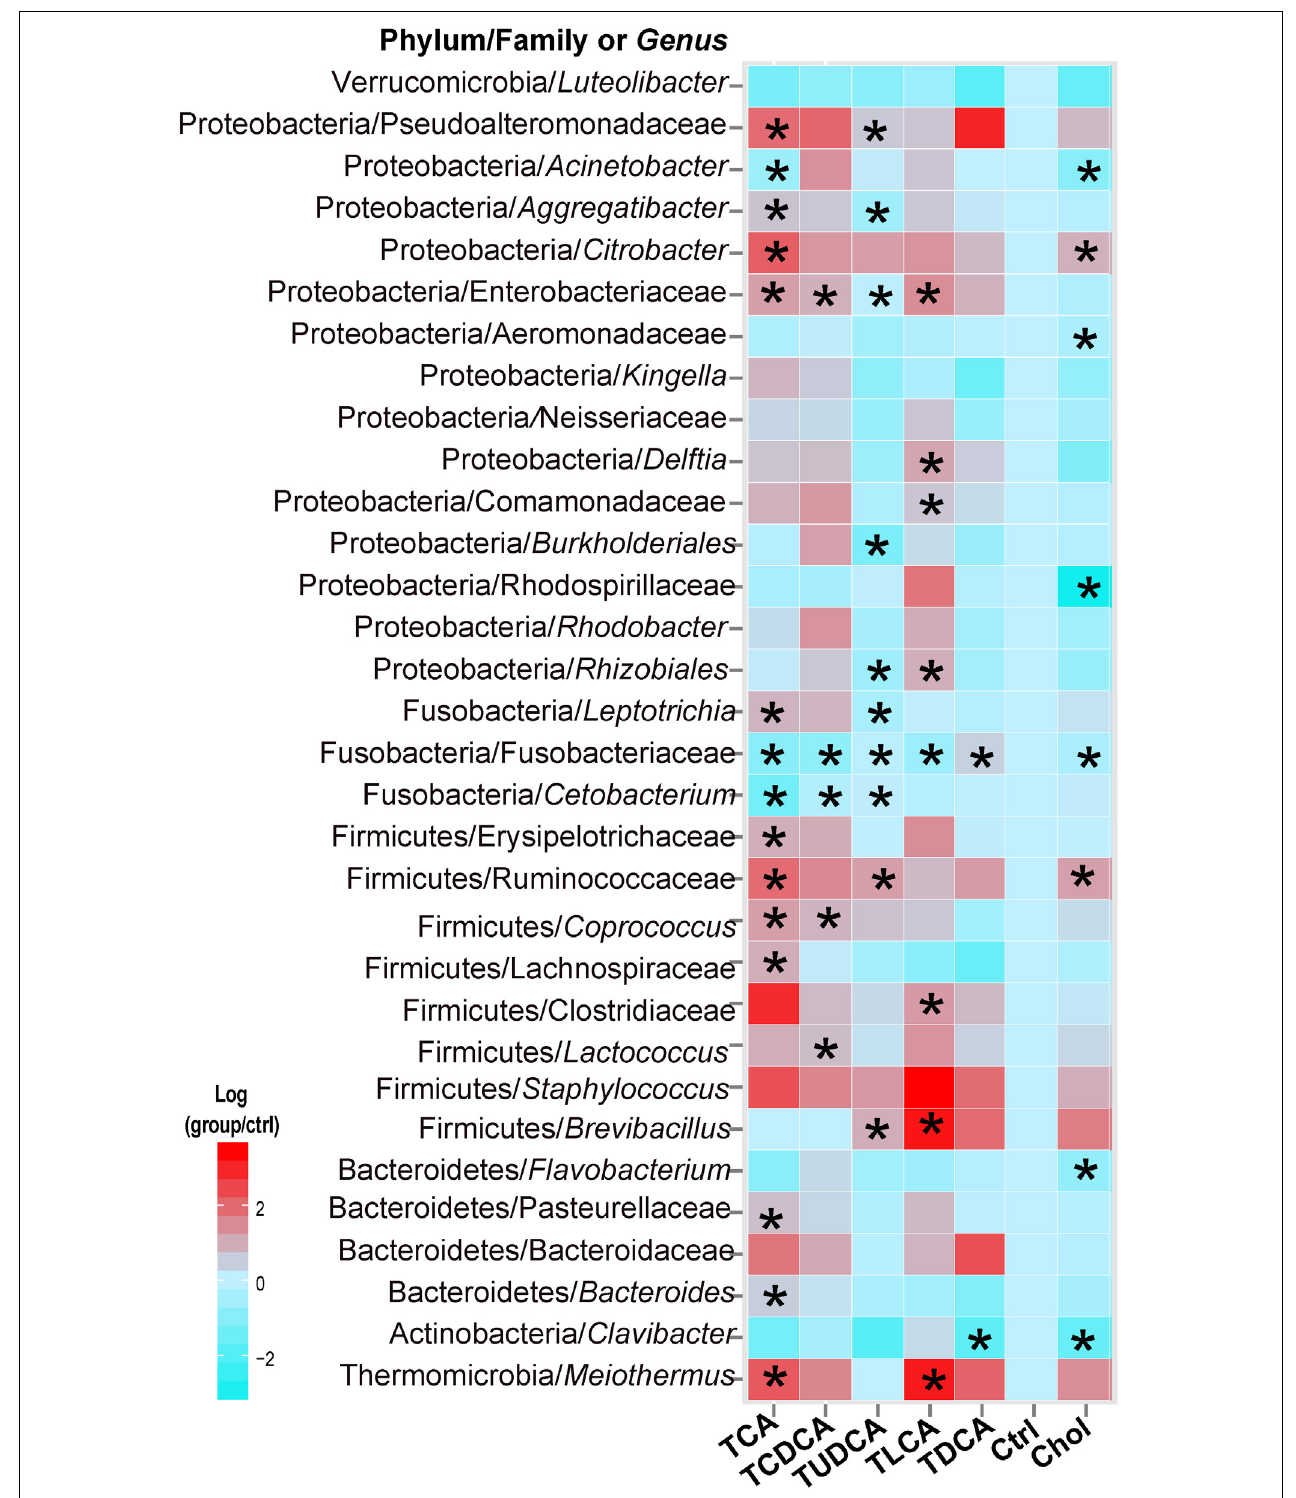
FIGURE 3 | Thirty-two microbial taxa at the genus taxonomic level showed significant ( p < 0.05) differences (in comparison to the Ctrl group) using the nonparametric Kruskal–Wallis test correcting for multiple comparisons with the Benjamini–Hochberg false discovery rate (FDR). Pairwise comparison of each group with the Ctrl group was tested using t -tests, and P -values < 0.05 are marked with “ ∗ ”. Where a taxon could not be precisely identified to the genus level, only a family name is indicated.